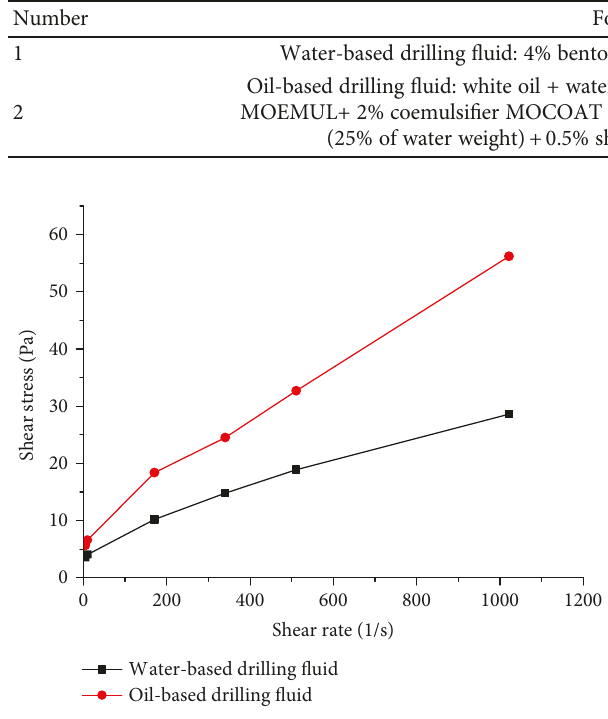
Figure 6: The fl ow curves for the drilling fl uids. Table 5: The results of water and bentonite slurry fracturing experiments.